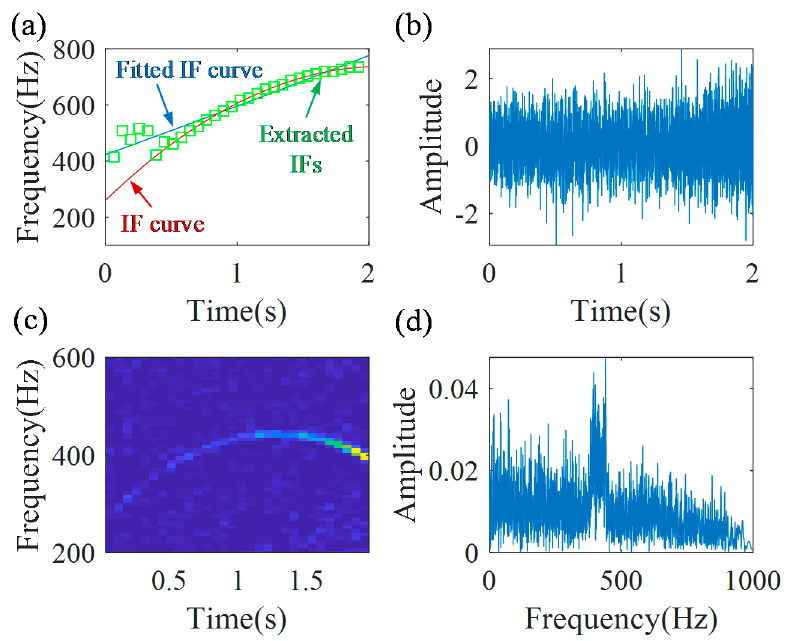
Figure 5. The first demodulation results by the traditional GDT: ( a ) extracted IFs; ( b ) first demodulated signal; ( c ) TFR of first demodulated signal; and ( d ) the spectrum.